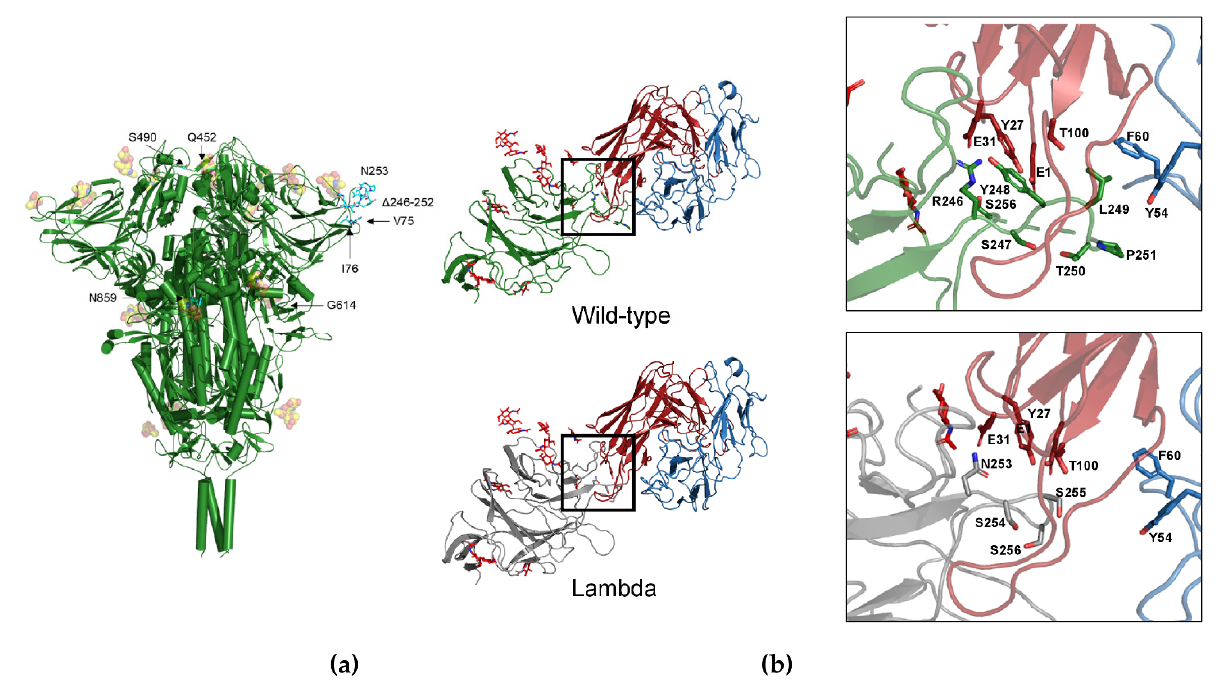
Figure 2. ( a ) Map of the Lambda mutations of the trimeric Spike structure. Only one mutation per monomer is indicated. Glycans are indicated as orange sphere models ( b ) interface chain A NTD-4A8. The mutant NTD was modelled via Swiss-Model and superposed to the wild-type domain of the complex. Interface interactions and energies calculated by PRODIGY were compared. Comparison of the interfaces between the wild-type (green cartoon, top) and the Lambda NTD (grey cartoon, bottom) and the mAb 48A at the deletion region. Red and blue cartoons indicate the heavy and light chain, respectively. Side chains in the deleted loop and the interacting residues are indicated with stick models and labelled. Sequence numbering refers to the wild-type Spike. Glycans are reported as red sticks.